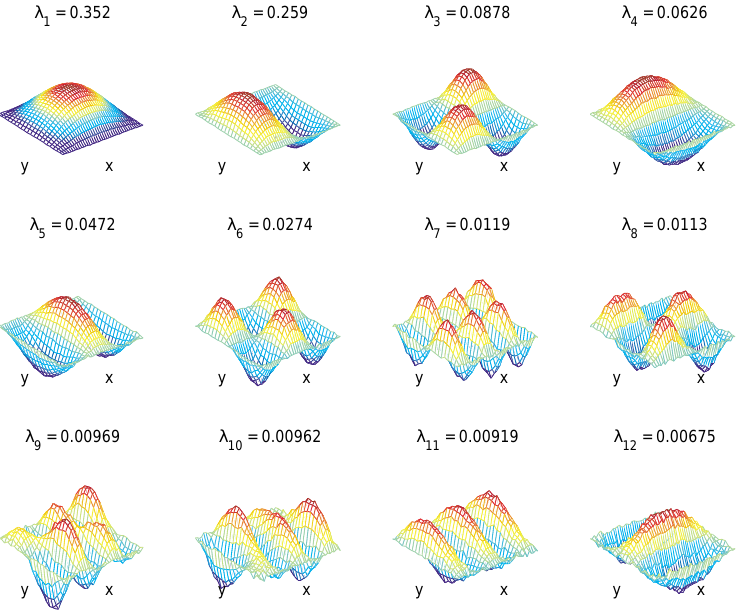
Fig. 13. Effect of noise contamination on the